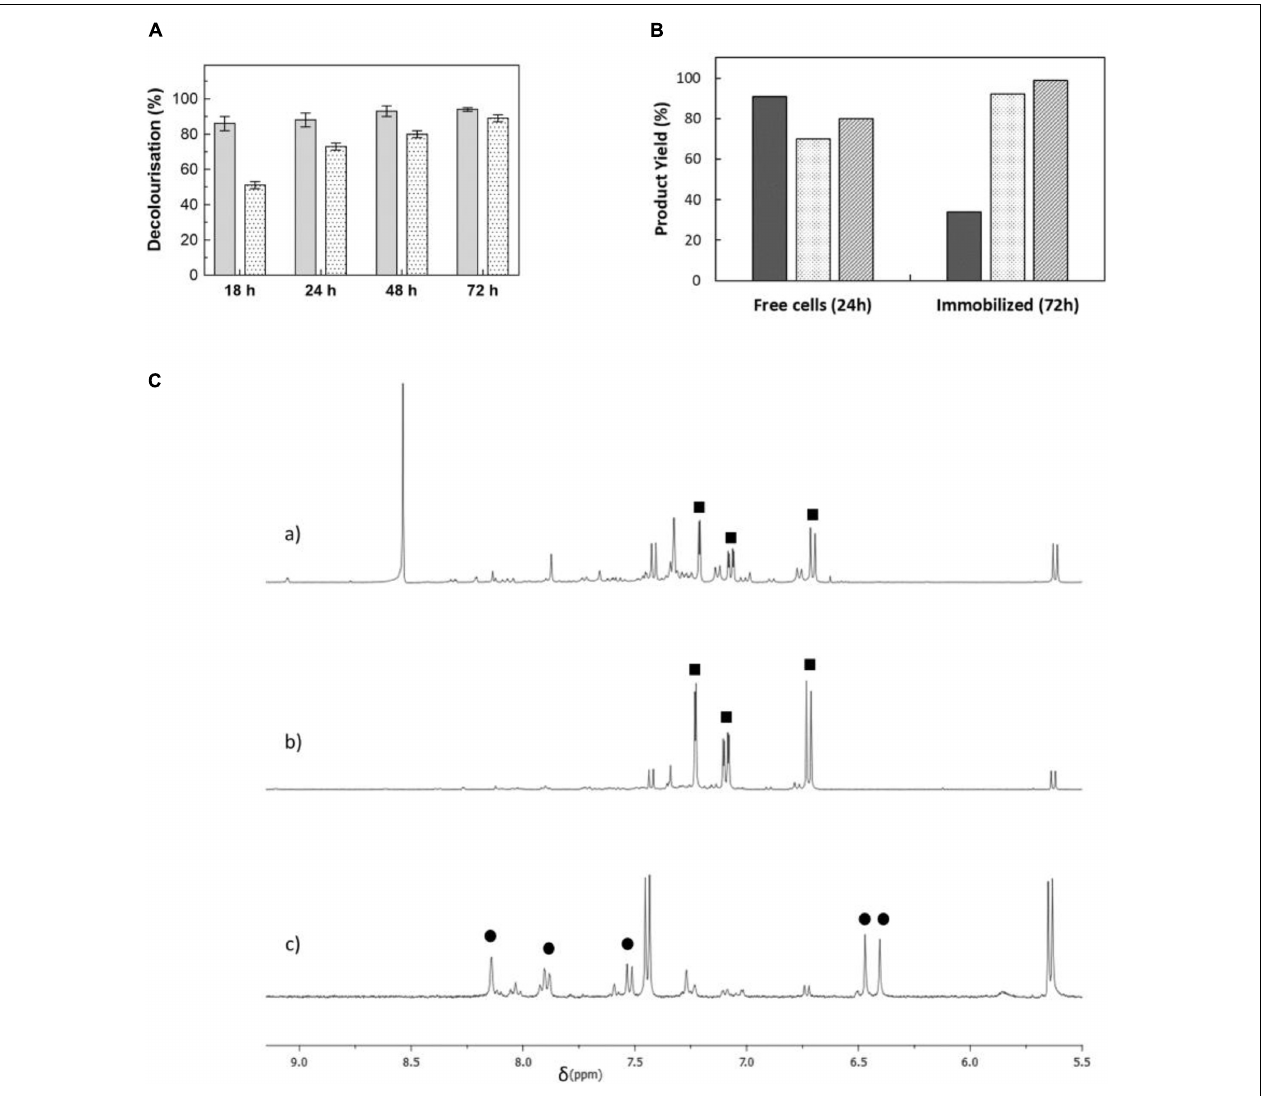
FIGURE 2 | (A) Time-course decolourisation of MB9 using free (light grey bars) and immobilised (dotted bars) cells containing PpAzoR azoreductase (60 mg DCW ml − 1 ) at 30 ◦ C in static conditions. (B) Yields of SAHBS in processes using free and immobilised cells of Escherichia coli Tuner (light black), BL21 star (light grey), and KRX cells (dark grey). (C) 1 H-NMR spectra (aromatic region) of reaction mixtures containing MB9 with (a) free or (b) immobilised E. coli KRX cells overproducing PpAzoR in static conditions at 30 ◦ C and (c) after addition of immobilised E. coli KRX cells overproducing CotA-laccase under stirring conditions at 37 ◦ C. Resonances due to SAHBS (filled squares) and compound 7 (filled circles) are